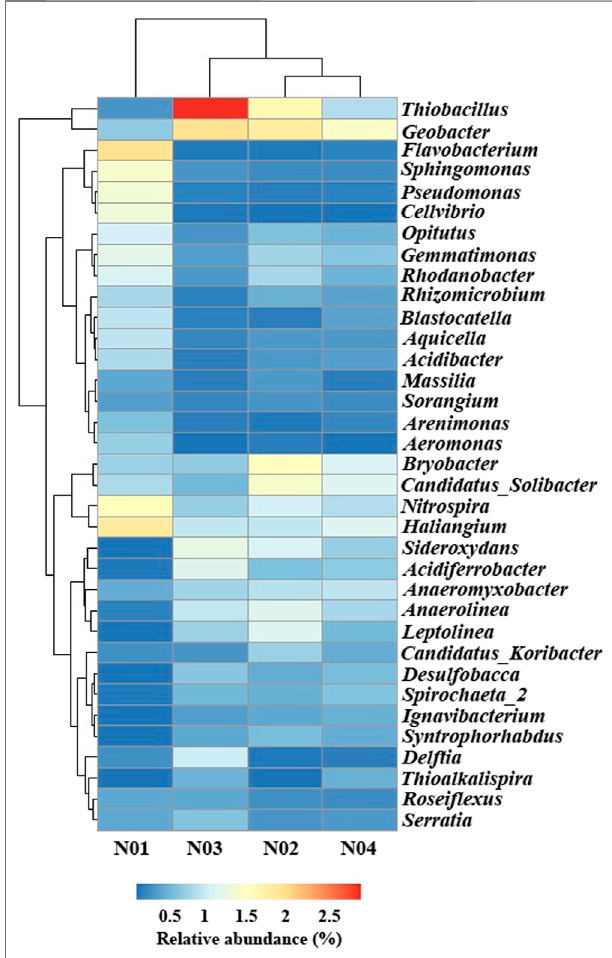
FIGURE 4 | Relative abundances of top 35 microbial genrea aross different samples at four